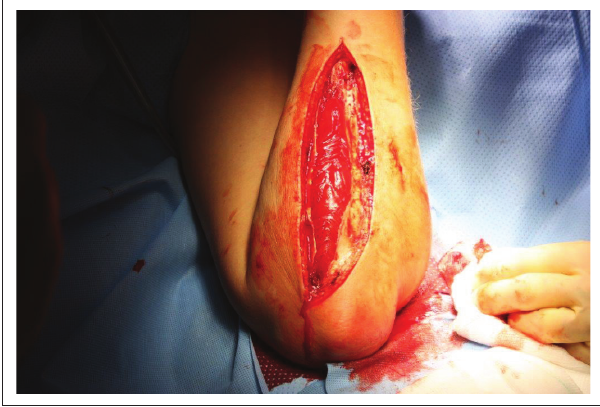
FIGURE 5: Open fasciotomy of the left forearm exposing the intermuscular septum and fascia.